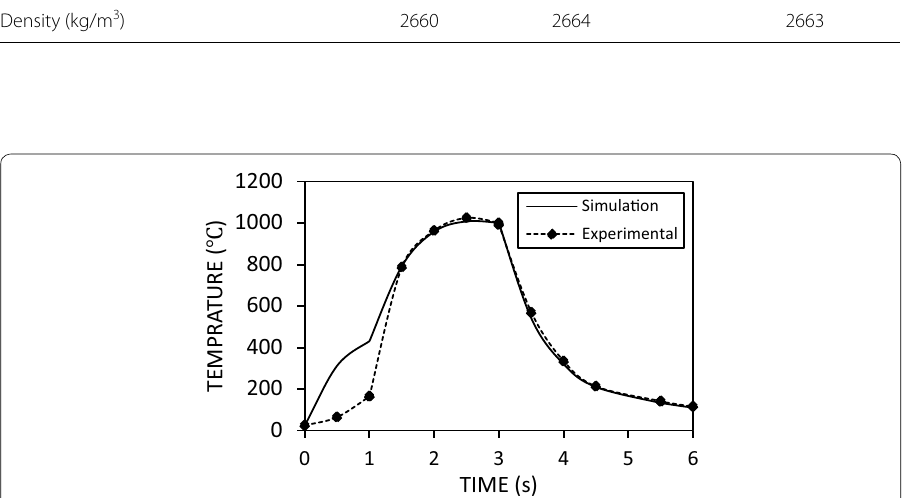
Fig. 3 Comparison of the laser drilling heat distribution in numerical models and experimental for